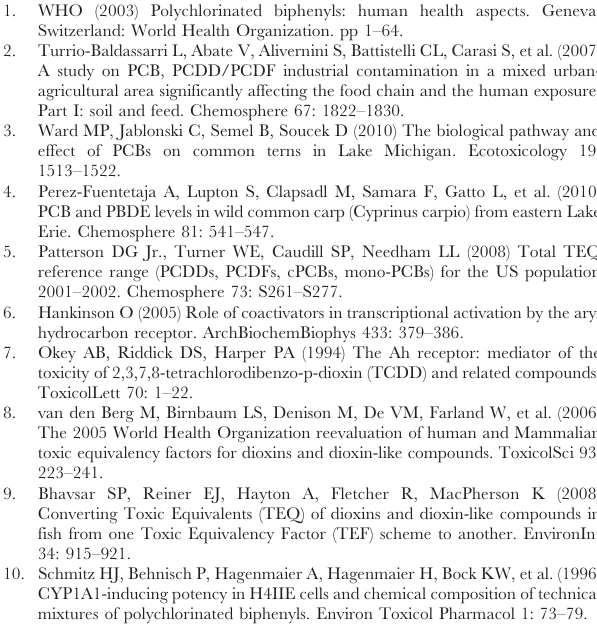
Figure S2 PCB 126 does not affect total intracellular ATP content. Total intracellular ATP is not impacted by PCB 126 (100 nM) after incubation in 5 mM or 10 mM glucose- containing serum-free medium. Data are average of 2 experi- ments; error bars are 2 / + SD. Note that the effect of glucose on total intracellular ATP tended towards statistical significance (p , 0.10). Figure S3 PCB 126 does not allosterically affect GNG from lactate. Addition of PCB 126 only at the onset of the GNG assay, and maintaining its presence throughout the standard four- hour collection period did result in suppression of forskolin- stimulated GNG from lactate. Note that data are the sum of four independent samples collected at one-hour intervals; *p , 0.05 for forskolin effect relative to respective 2 / + PCB condition. Data are average of 2–3 experiments; error bars are 2 / + SD. Figure S4 Myricetin is not cytotoxic in the presence or absence of 100 nM PCB 126. At the maximally effective dose of 25 m M, myricetin does not increase intracellular LDH release nor impact total LDH activity, independently or in conjunction with PCB 126 (100 nM). Other final-round candidate inhibitors